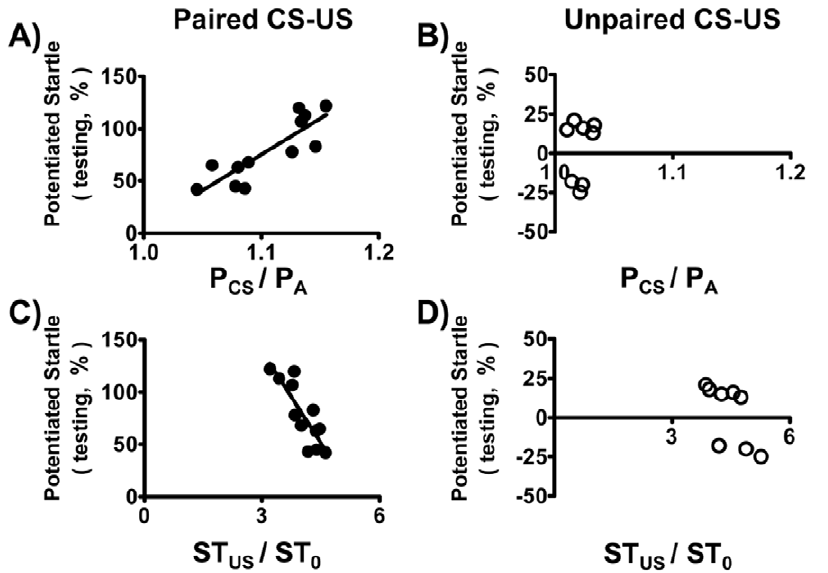
Figure 6. P CS /P A and ST US /ST 0 in the learning session forecasted the performance of fear-potentiated startle. The trial-averaged values of both parameters in training sessions under paired CS-US conditions effectively established the fear-potentiated startle (A, C), but those under unpaired CS-US conditions were unable to do so (B, D).